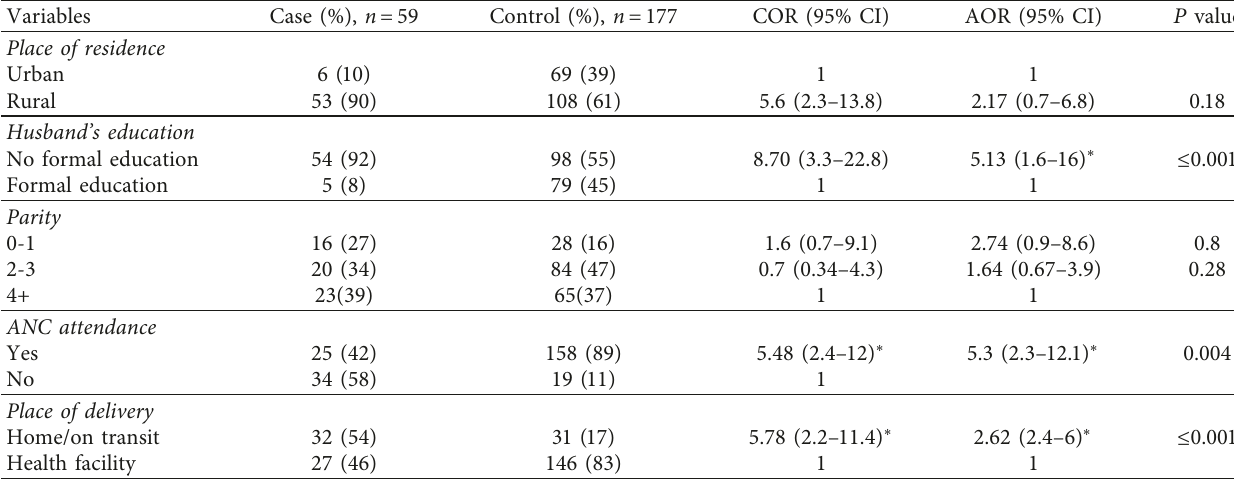
Table 6: Bivariate and multivariate logistic regression analysis of factors associated with maternal death at pastoralist area of Borena zone, Oromia region, Ethiopia,